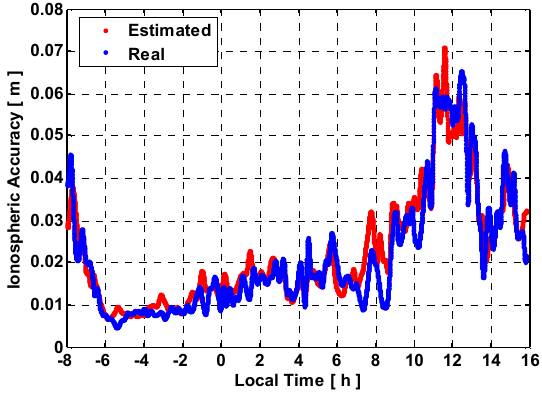
( d ) Figure 4. ( a ) distribution of peak-to-peak amplitudes of estimated accuracy of ionospheric